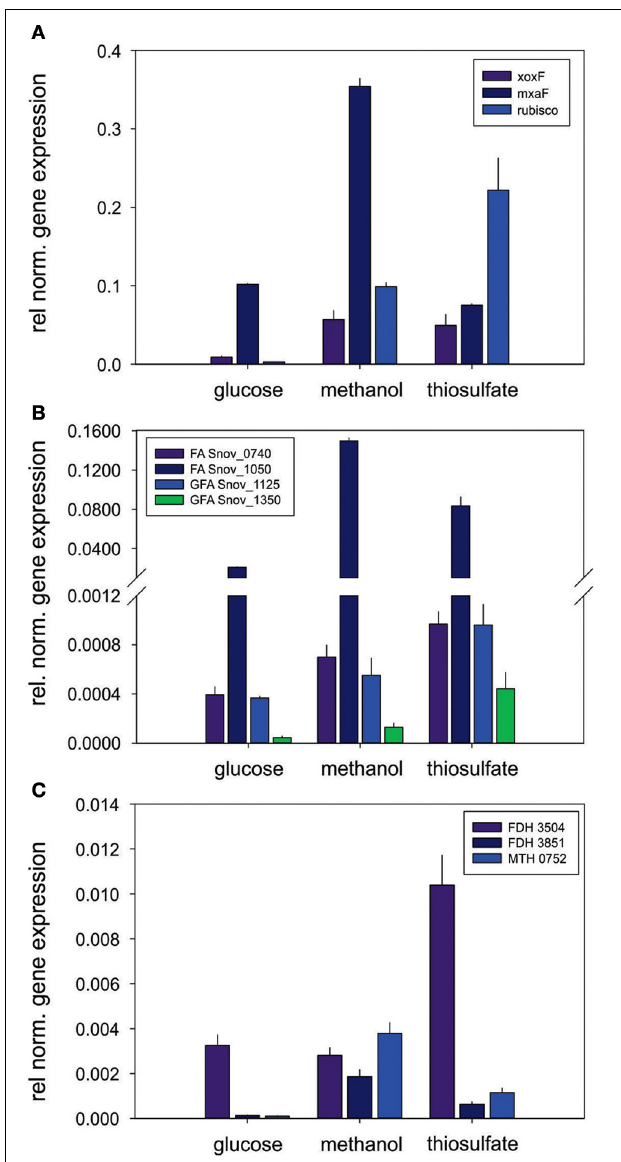
FIGURE 4 | Expression of genes involved in methylotrophy in S. novella . (A) Methanol oxidation and carbon dioxide fixation (Calvin cycle), (B) Formaldehyde activating enzymes, (C) Formate dehydrogenases. Error bars represent the Standard Deviation of the mean, gene expression was normalized relative to the expression of the 16S RNA